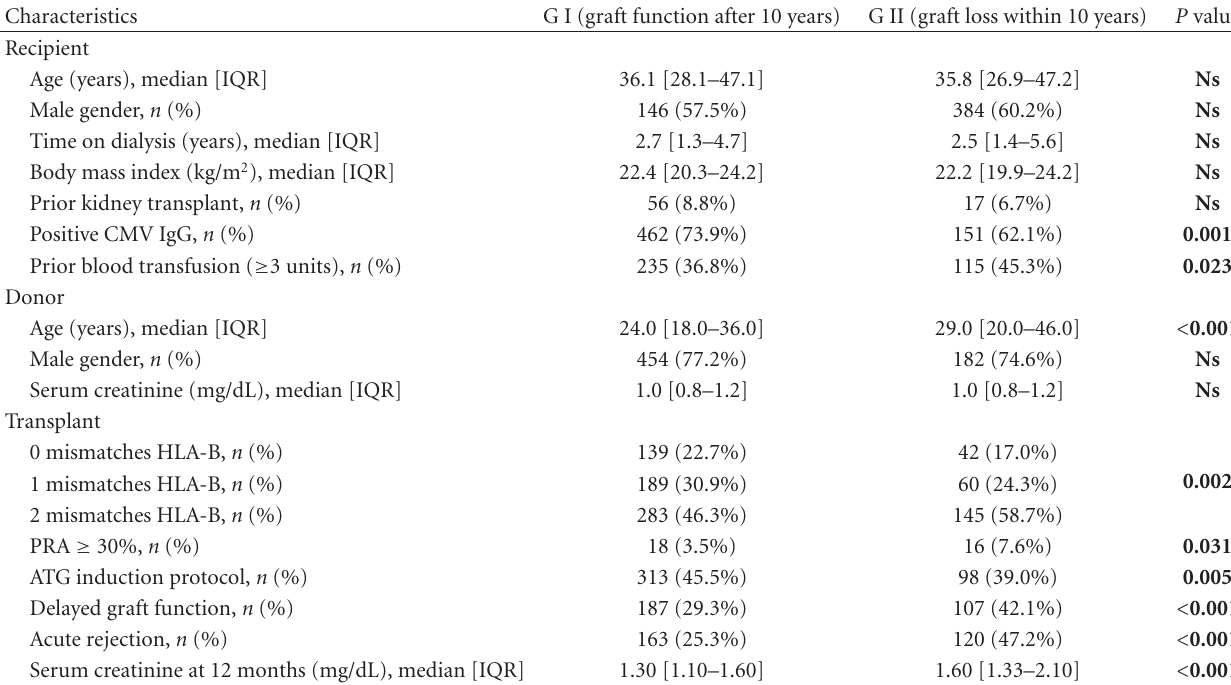
Table 2: Comparison of recipient, donor, and renal transplant characteristics between the two groups (graft function after 10 years versus graft loss within 10 years).